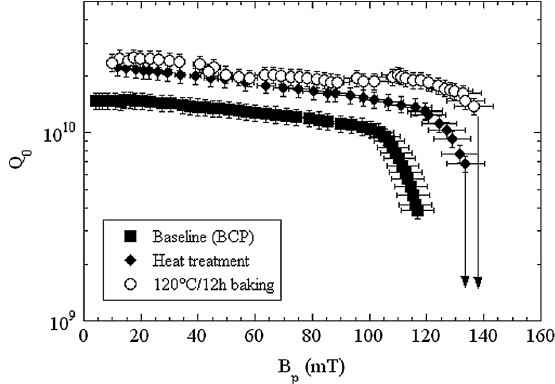
FIG. 13. Q vs B measured at 1.7 K on a large-grain CEBAF p 0 single-cell cavity after the baseline test (squares) and after the injection 800 (cid:1) C = 3 h , 400 (cid:1) C = 20 min with 1 (cid:5) 10 (cid:2) 5 mbar N 2 heat treatment (triangles). The round symbols are the data after additional in situ baking at 120 (cid:1) C for 12 h. H O was 2 (cid:5) 10 (cid:2) 8 mbar , the pressure of N was 6 : 7 (cid:5) 2 2 10 (cid:2) 9 mbar , and that of CO was 4 (cid:5) 10 (cid:2) 9 mbar . After the 2 heat treatment the cavity was degreased for 1 h, followed by HPR for 1 h. The rf test results at 2 K are shown in Fig. 14 (labeled ‘‘Heat treatment 2’’): the low-field Q 0 improved by about 26% while no Q drop was found up to a quench field of 118 mT. Temperature maps measured during the baseline test showed some hot spots in the equator region similar to the ones observed in the previous tests. These hot spots were significantly reduced after the heat treatment and the quench location was at location 20 (cid:1) , sensor 11. Temperature maps at the highest field achieved during the baseline and after the heat-treatment tests are shown in Fig. 15.